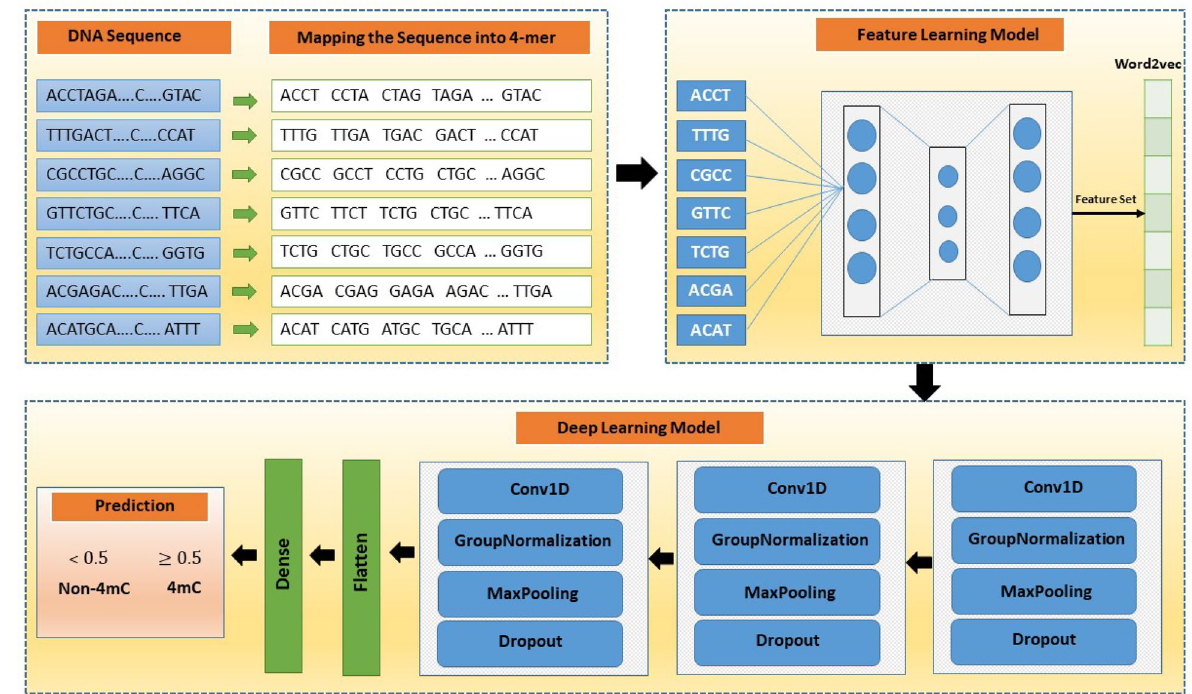
Figure 1. Illustration of complete architecture of